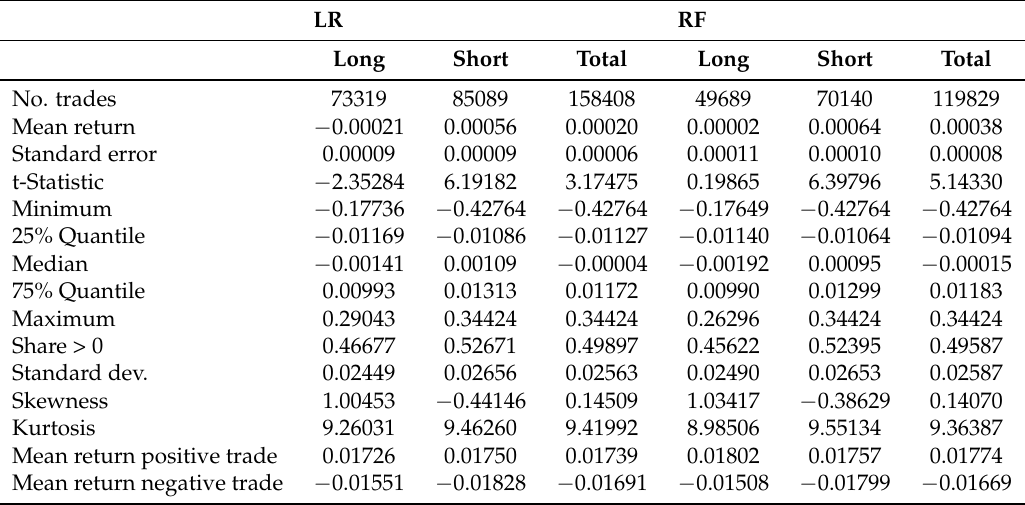
Table 1. Key return characteristics on the level of individual round trip trades for the logistic regression (LR) and the random forest model (RF) when investing in the top-3 and flop-3 coins, after transaction costs of 30 bps for the round trip